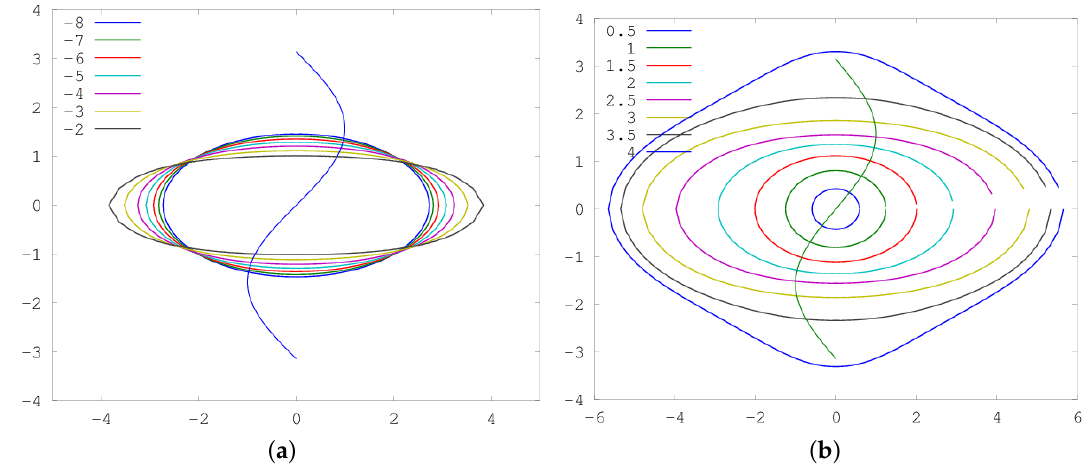
Figure 3. DBSA with the two x and y moments taken as Dirac constraints. ( a ) Vortex shape as a function of q 0 from − 8 to − 2. The jet vorticity is − 1 at the centerline and the area is fixed at 4 π 2 . ( b ) Vortex shape as a function of area defined by the initial radius r 0 from 0.5 to 4. The PV anomaly is q 0 = −